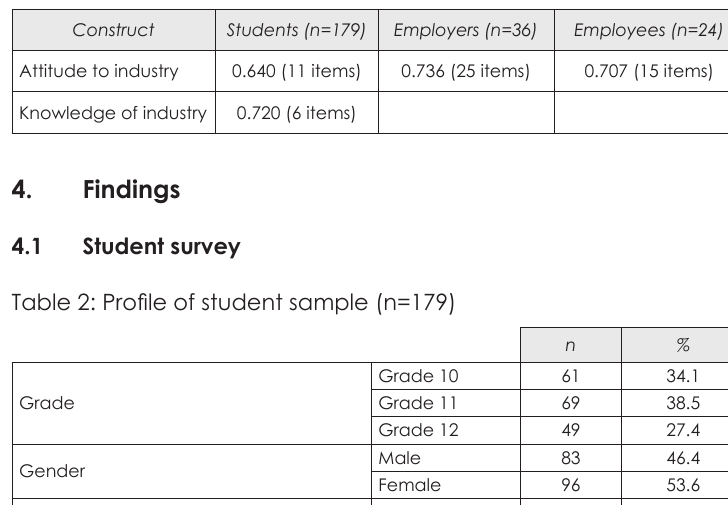
Table 1: Reliability statistics